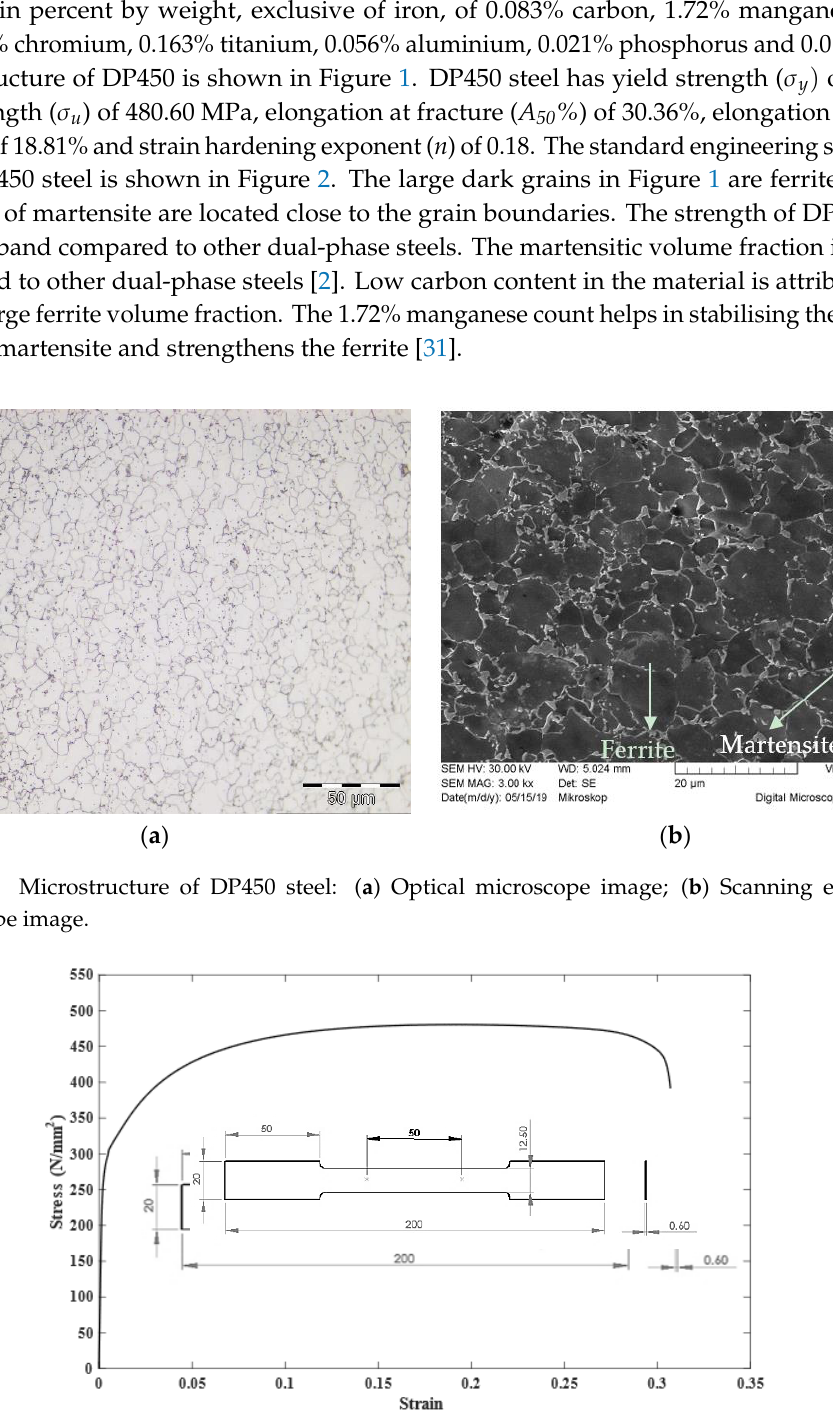
Figure 2. Engineering stress–strain curve of DP450 steel with specimen scheme (mm).